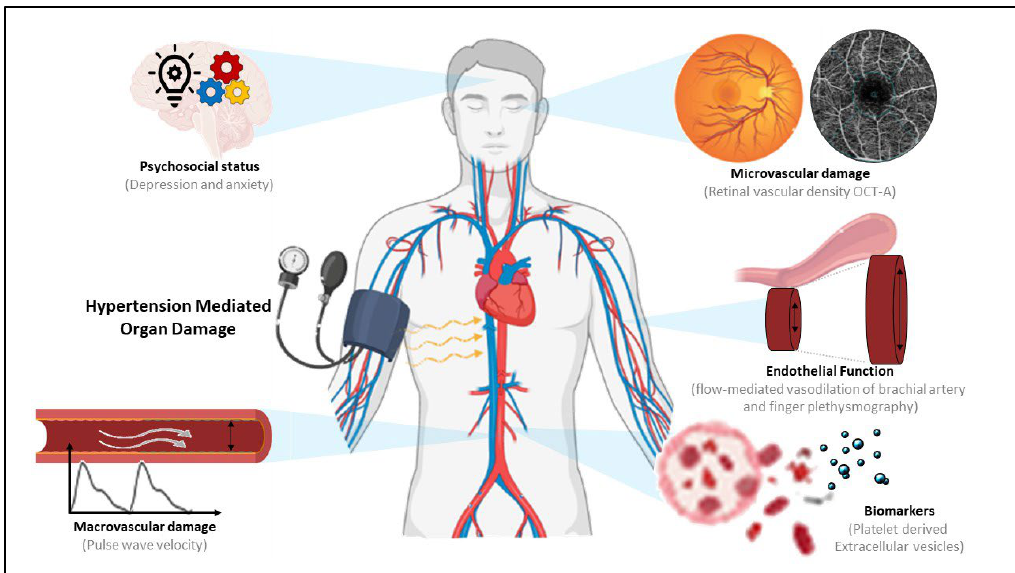
Figure 1. Schematic representation of the study techniques to evaluate hypertension organ damage (HMOD). Pulse wave velocity was used to assess arterial stiffness as a marker of macrovascular damage. Vascular density in different layers of the retina using optical coherence tomography–angiography (OCT–A) was used to evaluate microvascular damage. Flow-mediated vasodilation of the brachial artery and finger plethysmography were used to determine endothelial function. Indices of anxiety and depression were used to determine the psychosocial status. Platelet derived extracellular vesicles were evaluated as a possible biomarker of vascular damage.